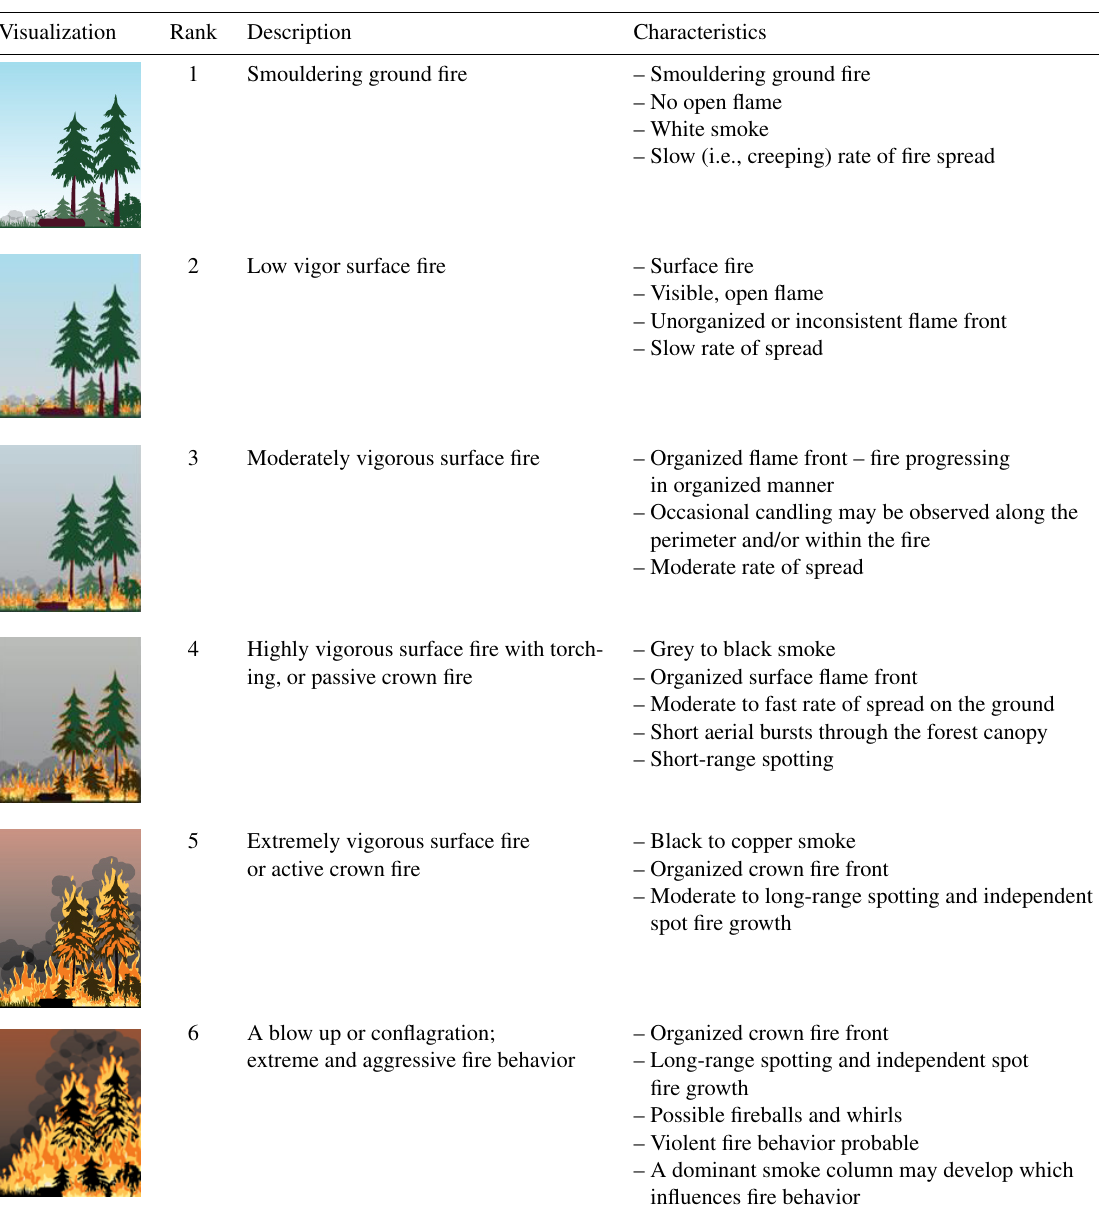
Table 3. Wildfire ranks used by the British Columbia Wildfire Service to determine the fire intensity.